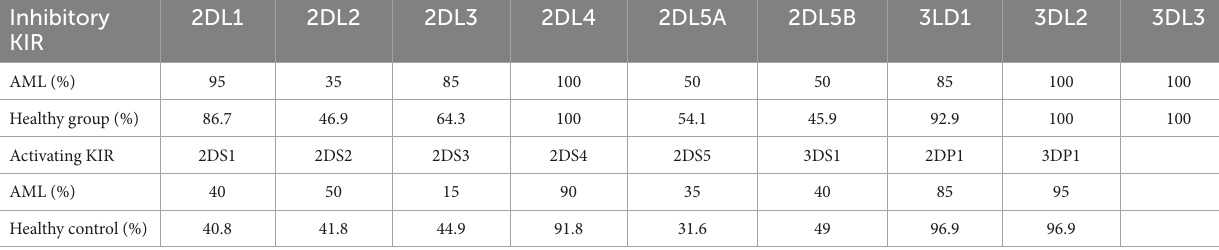
TABLE 3 The frequency of distinct KIR genes (%) in the AML and healthy control groups.